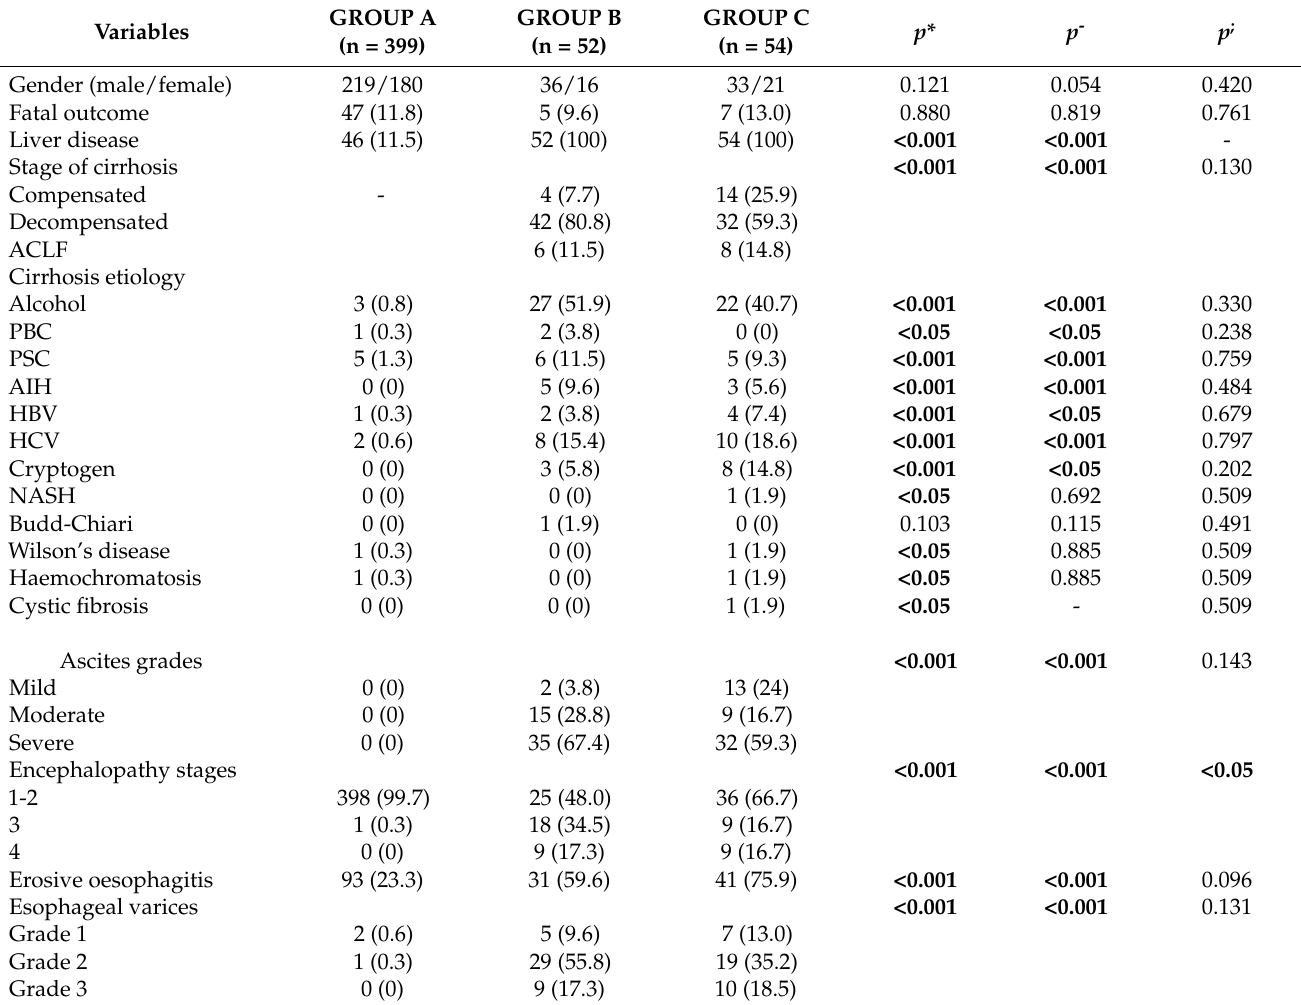
Table 2. Comparison of baseline characteristics across